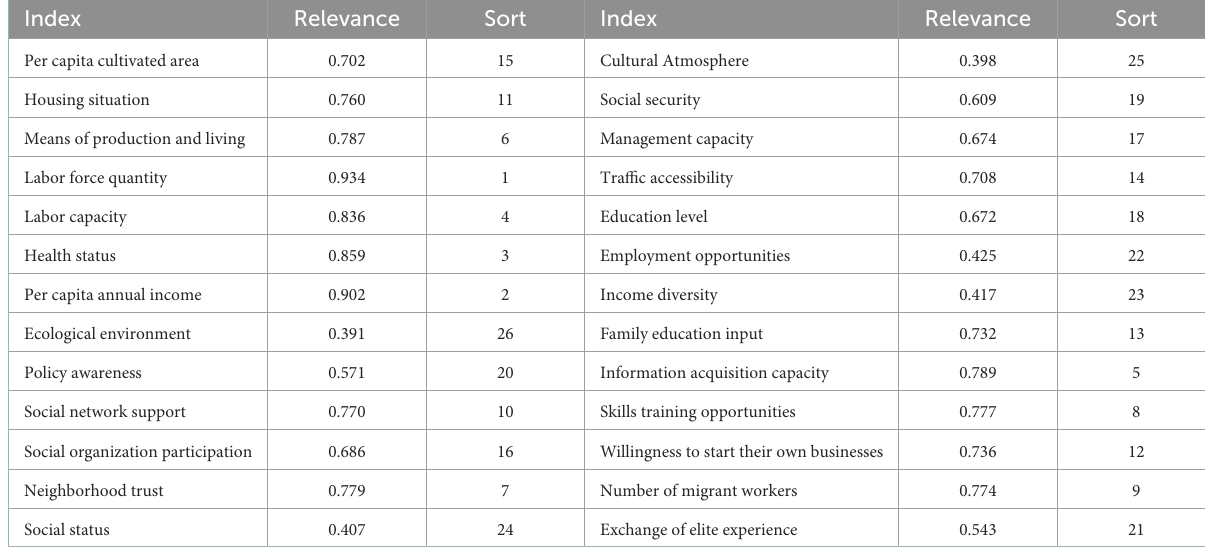
TABLE 2 Correlation and ranking results of livelihood resilience indices of resettled